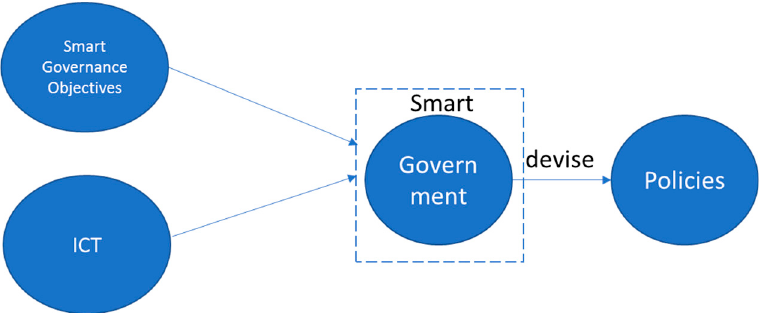
Figure 6. The relationship of Smart Government and Policy-making.